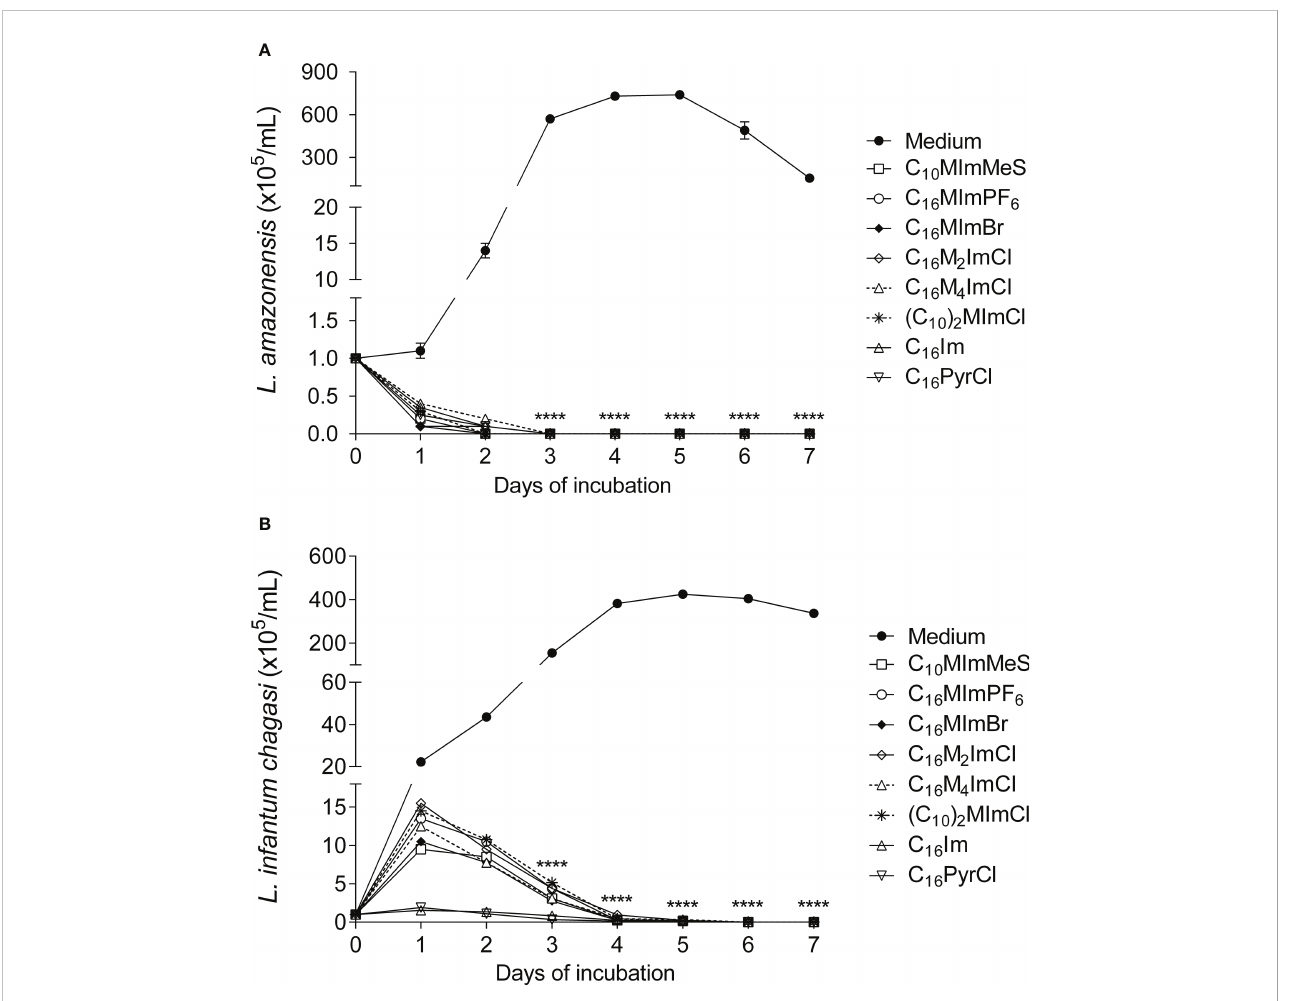
FIGURE 2 Growth kinetics of L. amazonensis and L. infantum chagasi promastigotes treated with the different compounds. L. amazonensis (A) or L. infantum chagasi (B) promastigotes in the stationary phase (1 × 10 5 cells/mL) were incubated with medium as control (M199 to L. amazonensis and Schneider ’ s medium to L. infantum chagasi ) or medium plus compounds at IC 50 values (for 48 h incubation), at 26°C, and the growth was determined daily using a hemocytometer. Data are expressed as means ± SEM (n = 5) and are representative of three independent experiments. The Two-way ANOVA repeated measures test followed by the Bonferroni ’ s test were applied. ****p <